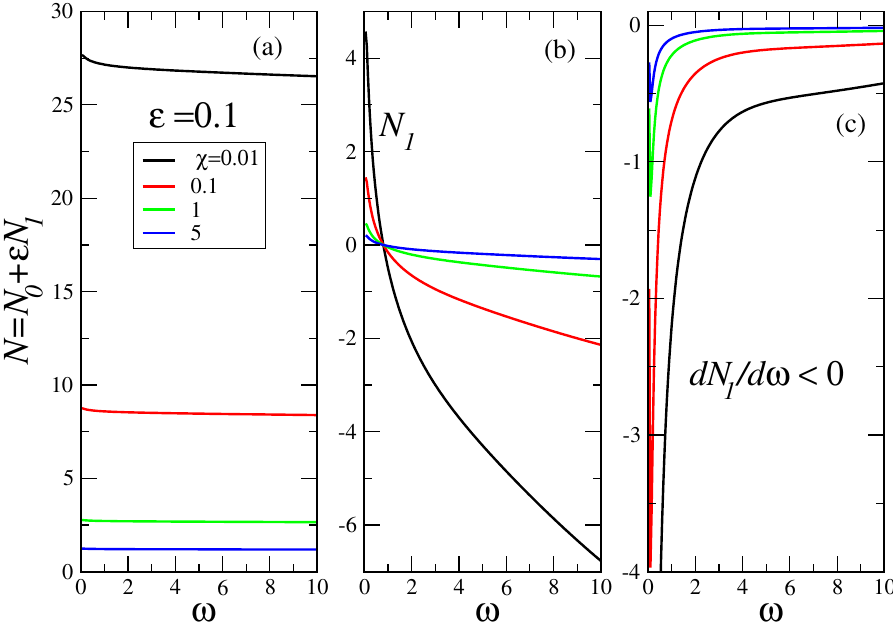
Figure 1. The “fractional soliton” norm, calculated in the first order of perturbation theory at several 1.9 ( ε 0.1 , legend in panel ( a )). As first order corrections (panel ( b )) are nonlinearity parameters χ and α = = negative at ω > 1 , panel (a) shows the overall norm, which turns out to be positive as it should be. Panel ( c ) dN d ω , which are negative. At large ω the corrections at any χ sease to depend shows the derivatives dN / d ω 1 / ≡ 0 at ω χ on ω so that dN 1 / d ω . The larger , the more pronounced is latter → ∞ | | →